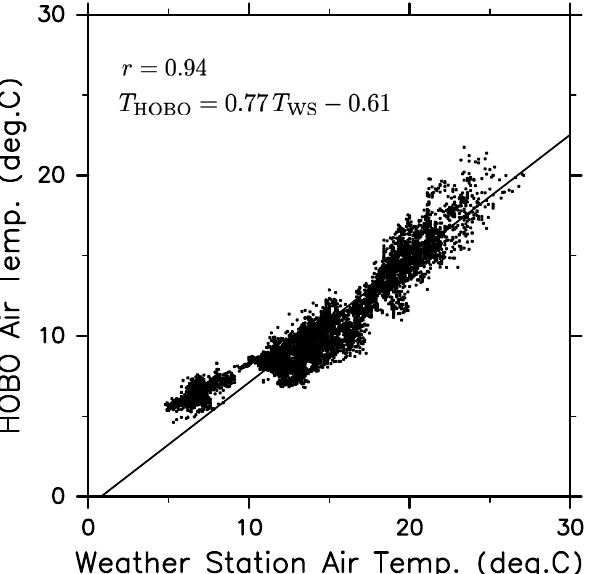
Figure 3. Scatter plot of observed temperature values by Weather Station sensor ( T WS ) versus those by HOBO sensor ( T HOBO ). Their correlation coefficient is r = 0.94. The linear regression equation ( T HOBO = 0.77 T WS − 0.61) is indicated by the slanted line.